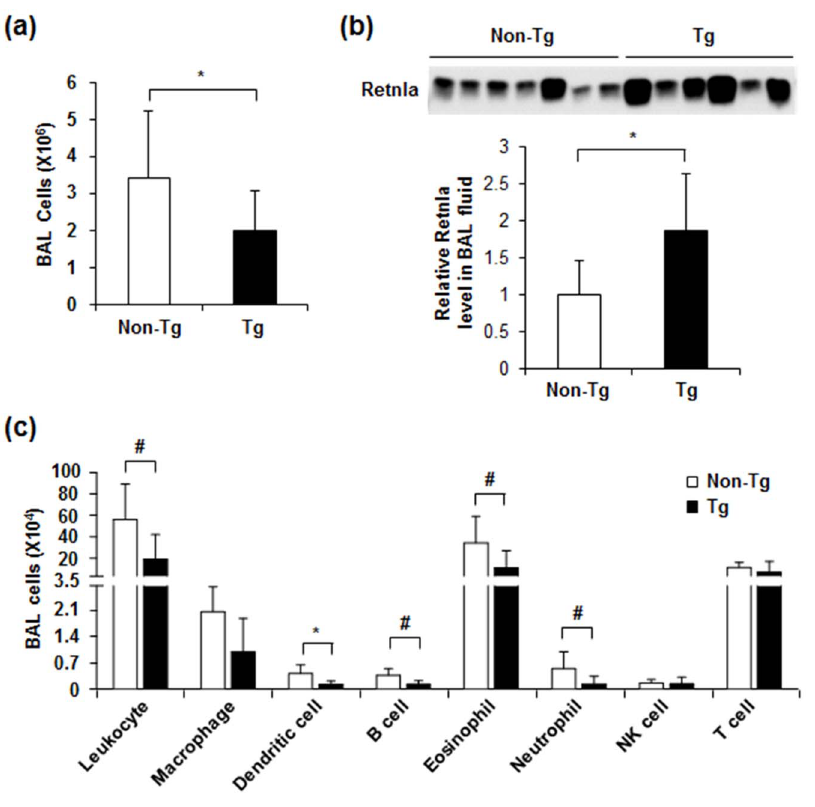
Figure 4. Retnla overexpression reduced immune cells in BAL fluid from OVA-sensitized/challenged mice. (a) Inflammatory cell infiltration was examined in BAL fluid from OVA-challenged Retnla- Tg and non-Tg mice (n 5 7 to 8 per group). (b) The level of Retnla protein in BAL fluid was analyzed by immunoblotting. Each lane represents an individual mouse. Band intensities were quantitated by computerized densitometry. (c) Immune cell populations in BAL fluid of Retnla -Tg and non-Tg mice were quantified by flow cytometry (n 5 4 for non-Tg, n 5 6 for Retnla -Tg). Data are presented as mean ¡ SD. Statistical analysis was performed with the Mann-Whitney U -test; * P , 0.05; # P 5